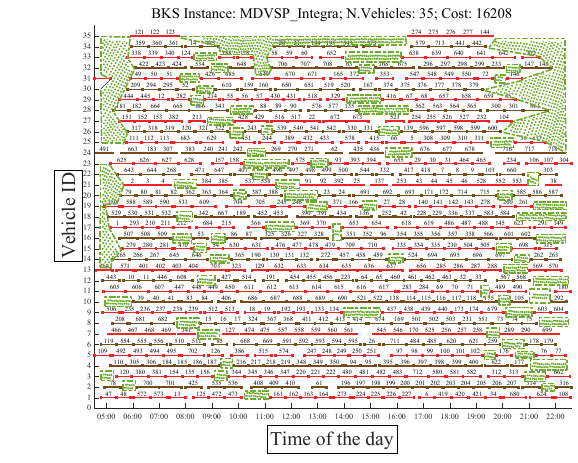
Fig. 15. Initial solution Fig. 16. Algorithm (GA+SP+MIP) impact in the resulting